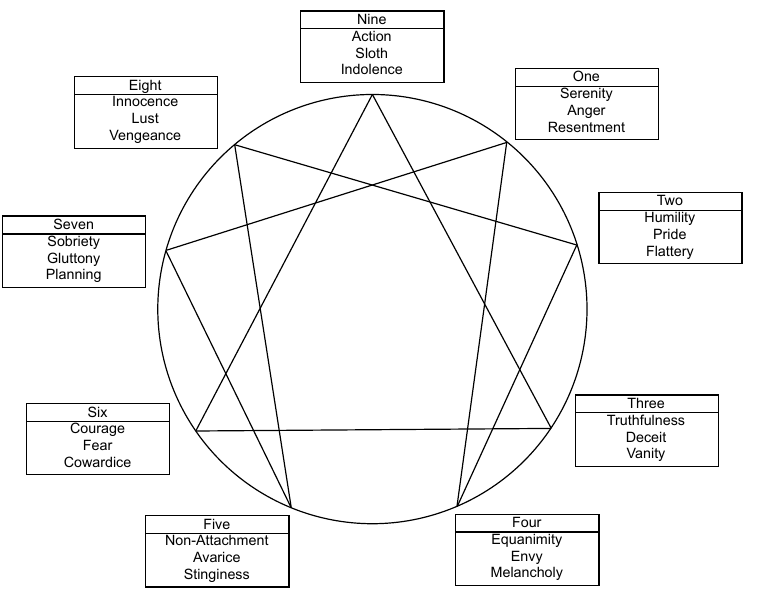
Figure 5. Enneagram types with their virtues, passions and ego-fixations as described by the Bolivian philosopher Óscar